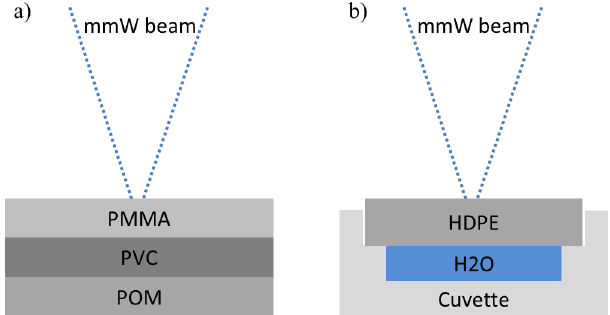
Figure 3. (a) Exemplary three-layer DUT consisting of discs made from POM, PVC and PMMA. (b) Custom-designed cuvette for in- vestigation of liquid solutions such as H 2 O. The HDPE layer acts as a Fabry–Perot